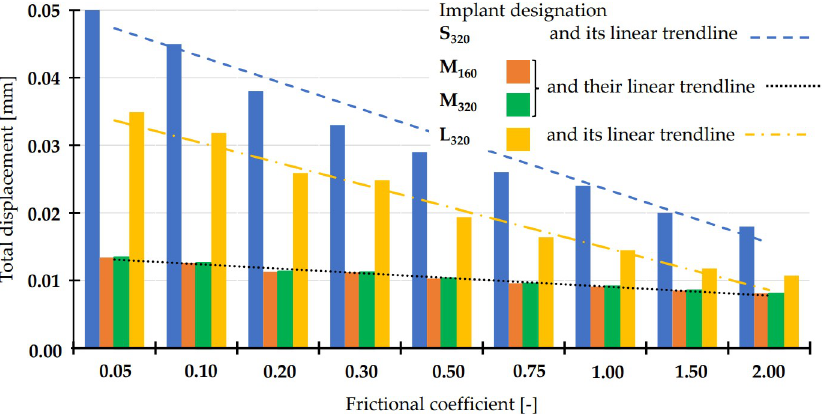
Fig 5. Reduction in the total implant displacements for different implant sizes with increasing frictional coefficient at BIC surface area computed according to Approach I . The increase in frictional coefficient simulated osseointegration in Approach I